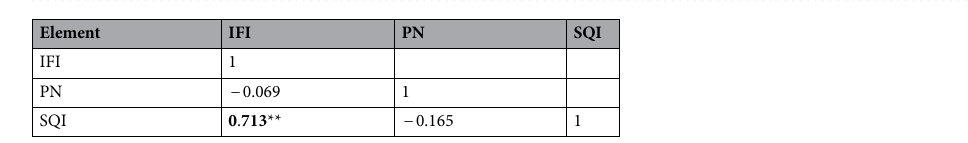
Table 6. Correlation analysis between IFI and PN. *Indicates P < 0.05, and the correlation is significant. **Indicates P < 0.01, the correlation is extremely significant.